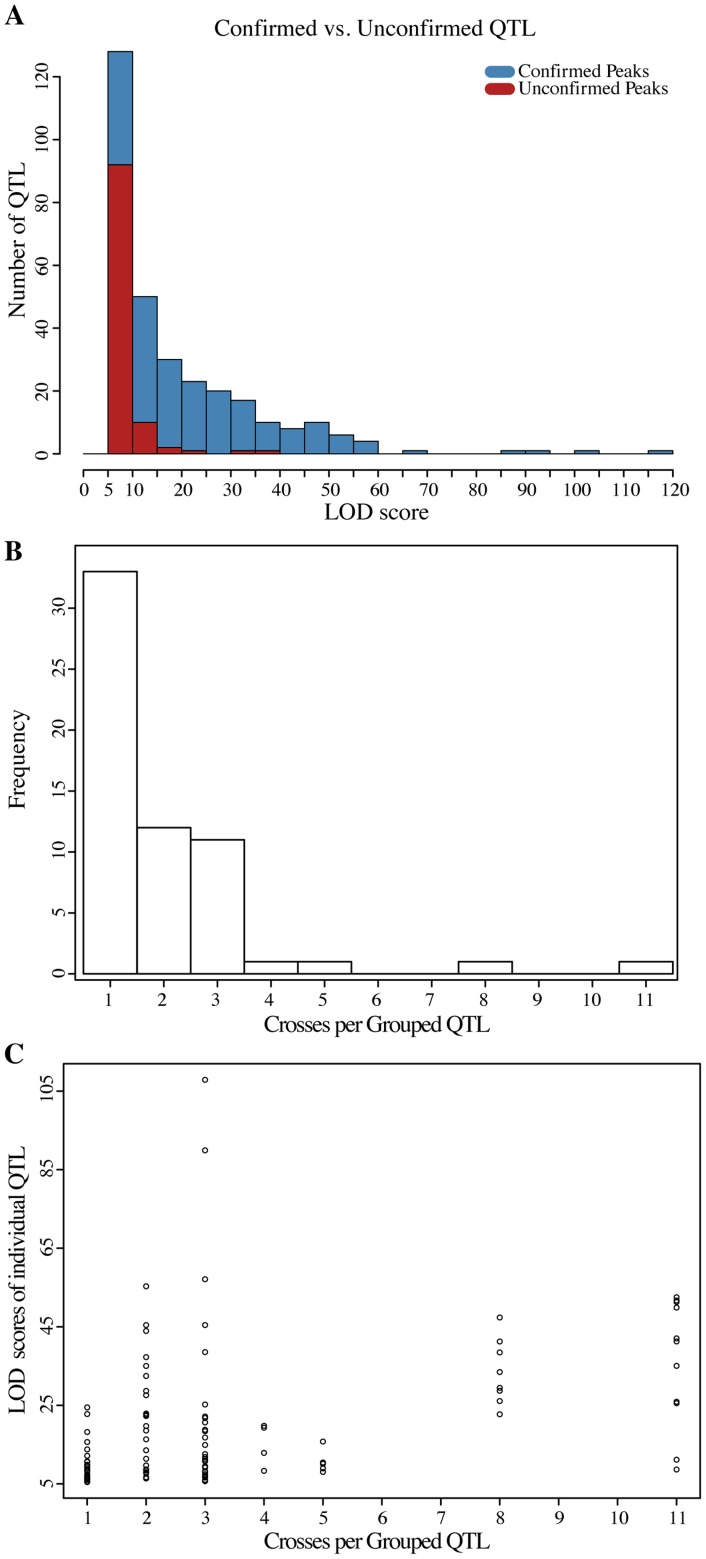
Analyses of QTL identified in the round-robin cross.(A) LOD score distribution of QTL detected in both of the MATa and MATα selections experiments compared to that of QTL only found in either of the two experiments. The majority of QTL that miss replication have LOD scores close to the threshold used to call QTL. (B) Histogram of the number of crosses per QTL group. Theoretically, assuming purely additive effects and perfect detection, each QTL should be observed in at least two crosses. (C) LOD scores of the QTL belonging to different classes of grouped QTL. Identification of QTL in only one cross is only partially explained by the lower LOD scores of this class of QTL (pearson correlation 0.417, p = 2.6×10−6).